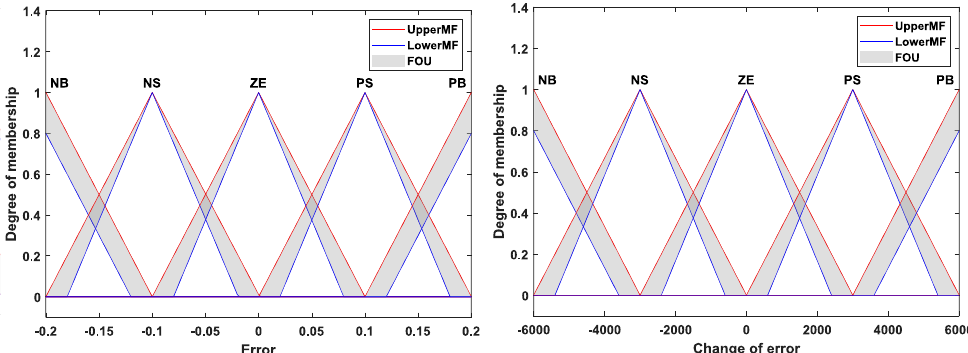
(NB)’ for two input variables are used to express the fuzzy variables.